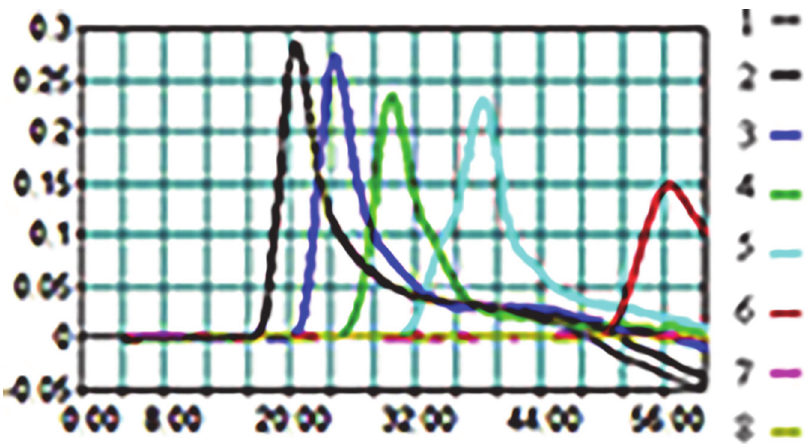
Fig 3. The amplification of STY2879-LAMP in detecting S . Typhi in simulated human stool samples. The assay was performed using simple heat-treated DNA samples from pre-enrichment simulation stool specimens spiked with different levels of S . Typhi (CT18) ranging from 2×10 7 * 2×10 1 CFU/g (sample 1 – 7); 8 is the negative control without the target DNA. The amplification curves of sample 1 and 2 are overlapping.